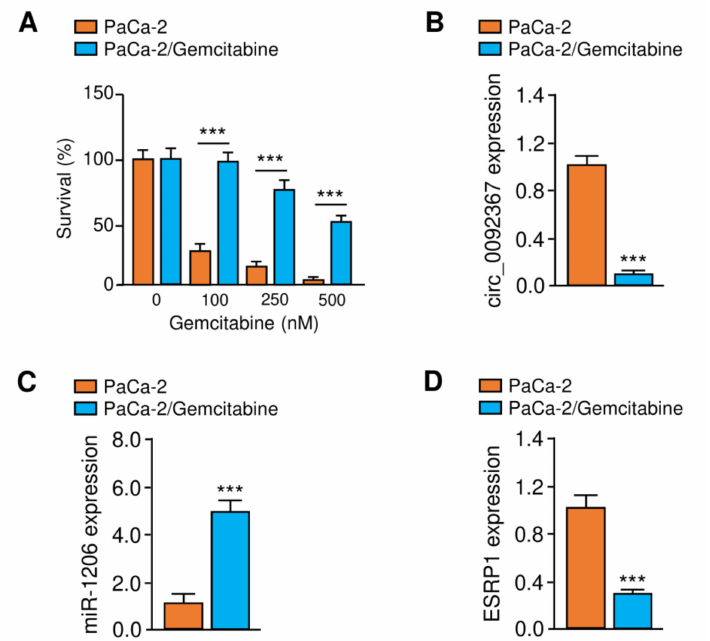
Figure 8. Expression of Circ_0092367, MiR-1206, and ESRP1 was examined in Gemcitabine-resistant PaCa-2 Cells. ( A ) CCK-8 assays were used to measure the effects of gemcitabine treatment on the survival of the parental cell line PaCa-2 and gemcitabine-resistant PaCa-2 cells. ( B – D ) Circ_0092367 ( B ), miR-1206 ( C ), and ESRP1 ( D ) expressions in gemcitabine-resistant PaCa-2/Gemcitabine cells and the parental PaCa-2 cell line were examined using qRT-PCR assays. The experiments in ( A – D ) were repeated three times independently with similar results. *** p